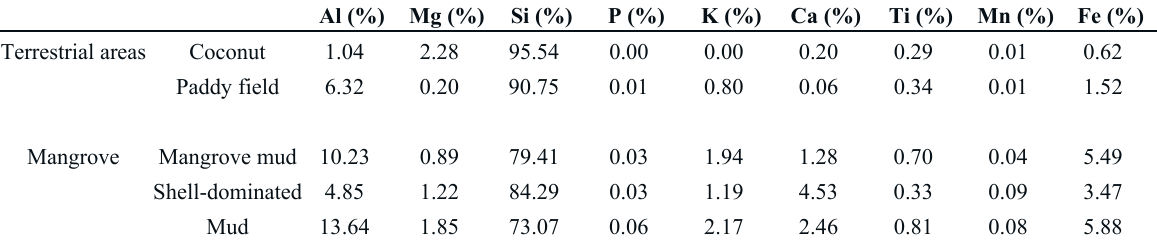
Table 3. XRF analysis of soils/sediments in terrestrial and mangrove ecosystems.